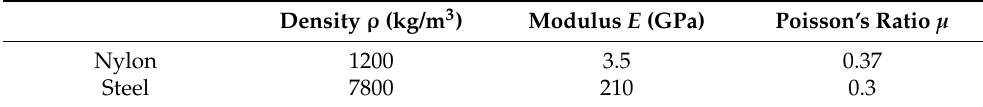
Table 2. Material parameters of the SPLCRR